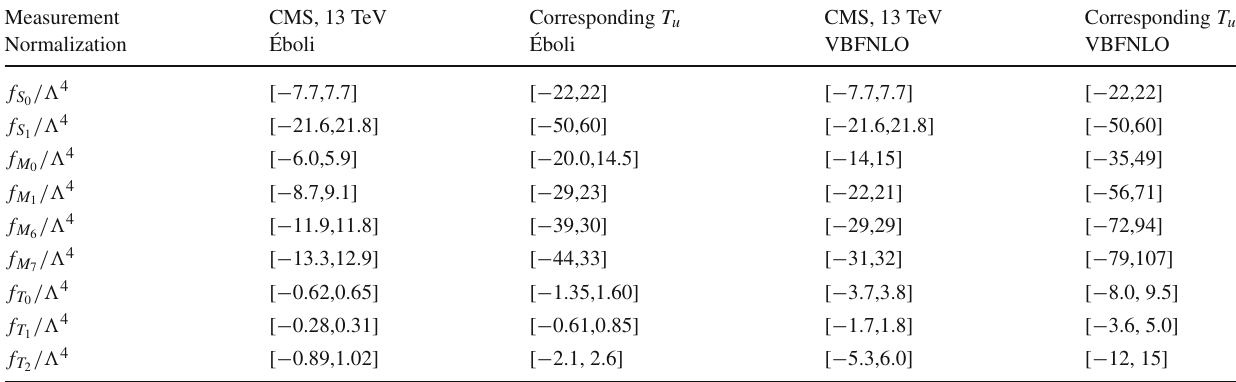
f i /(cid:2) 4 in the T u model (second column). Columns three and four give the corresponding numbers for the VBFNLO normalization of opera- tors. See text for further details